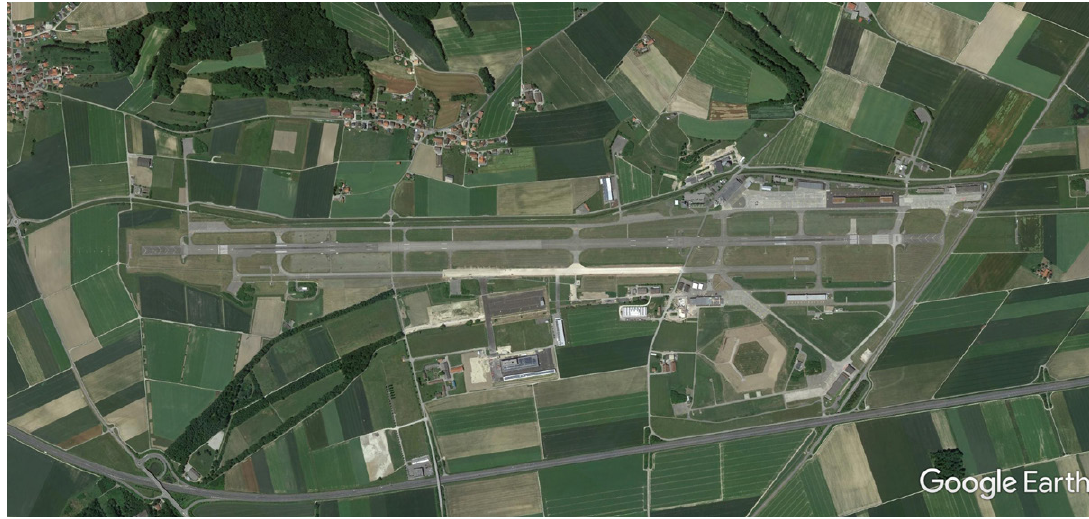
Figure 1. Aerial view of Payerne airport. The runway is classified as non-instrument. We can see the narrow width of the runway strip but also the CAT1 approach lights to either side. Arresting cables provisions are visible 450 m from threshold 0.5 and 750 m from the threshold 23. Strip width is 75